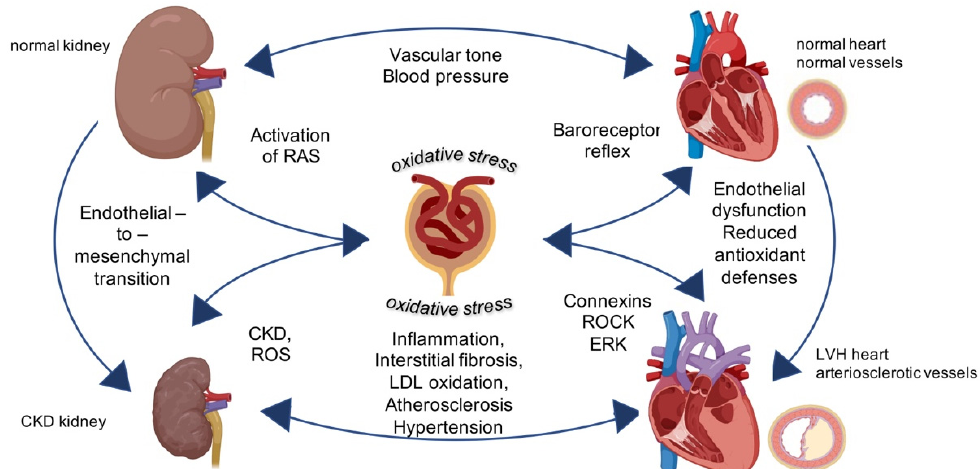
Figure 1. Central role of oxidative stress for cardiovascular-renal remodeling in kidney diseases. Physiological activity of kidney regulates vascular tone and controls blood pressure. The intracellular mechanisms triggered by oxidative stress targeting the kidney induce chronic kidney diseases and left ventricular hypertrophy (LVH) in the vessels and in the heart leading to general cardiovascular-renal remodeling. Image created with BioRender.com.